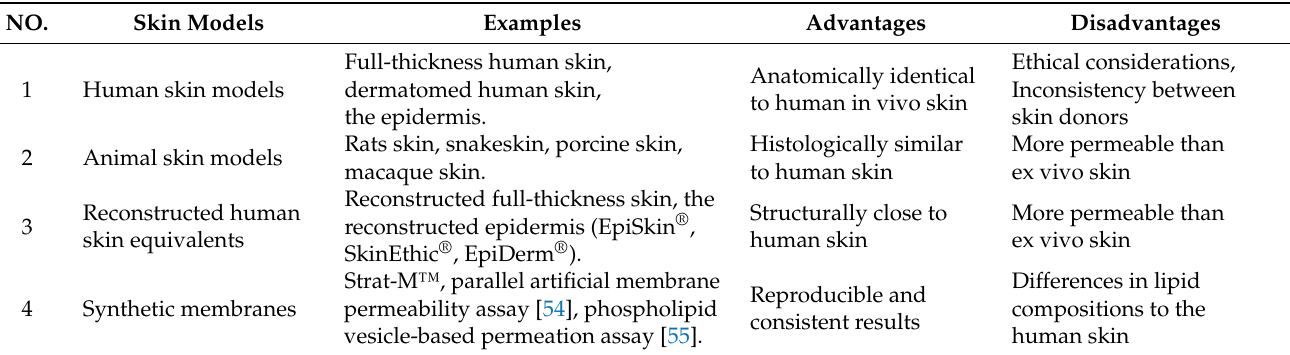
Table 3. Skin models used in IVPT and IVRT studies.